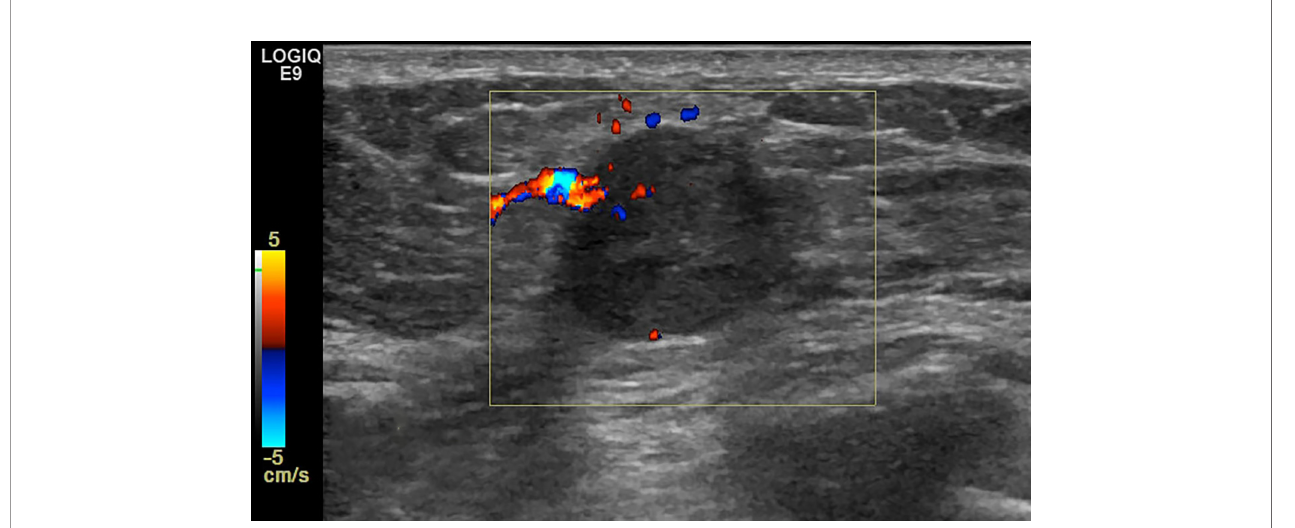
FIGURE 6 | Case 3: A 49-year-old woman with cPMBC presented with a hypoechoic mass (1.7 × 1.4 × 1.3 cm) in the right breast. The lesion presented with linear blood fl ow signal by color Doppler mode.